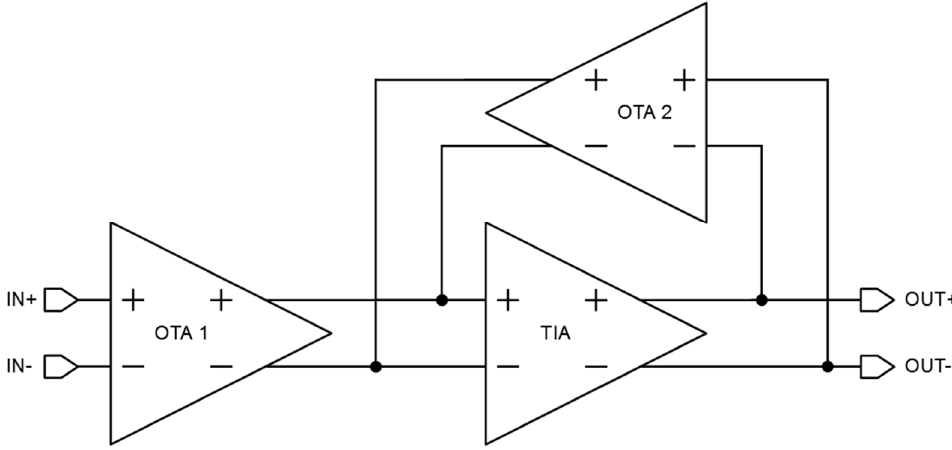
Figure 6. A simplified schematic diagram of the programmable gain amplifier.